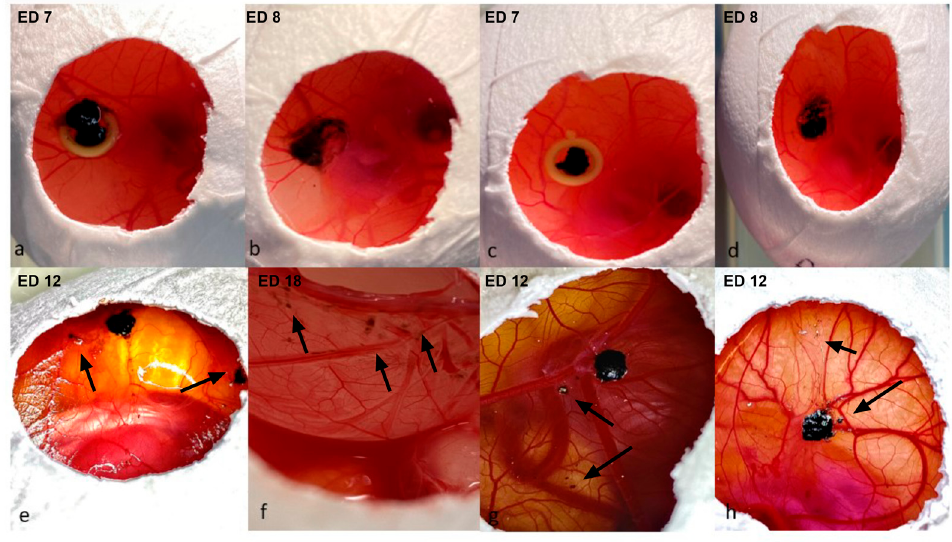
Figure 4. Detachment of the peripheral sections of the implanted uveal melanoma grafts, ( a – d ): implantation with Matrigel and a ring (group 2), ( e – h ) implantation without Matrigel or a ring (group 3). ( a , c ) Images of the implanted uveal melanoma patient-derived grafts with Matrigel and a ring on ED7 directly after engraftment; the larger tumor sample does not fit inside the ring, as depicted in images a, b, and d—dissociation and loss of cohesion in the periphery of the tumors directly after the removal of the rings on ED8. ( e , g , h ) Loss of cohesion and detachment of tumor segments from the main tumor body on ED12 in group 2, as indicated with arrows. ( e , f ) Invasion of the tumor depicted in image e into the lower CAM with loss of peripheral cohesion after the dissection of the embryo on ED18.